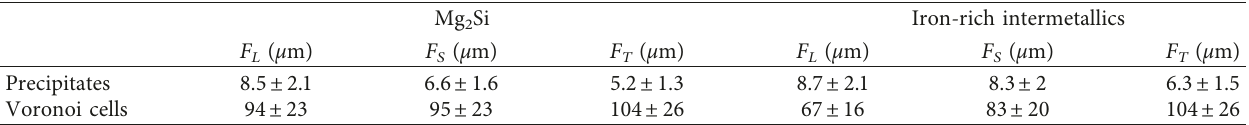
Table 2: Feret dimensions of coarse precipitates and Voronoi cells through L , S , and T directions. Deviation is estimated to about 25% owing to the threshold uncertainty.